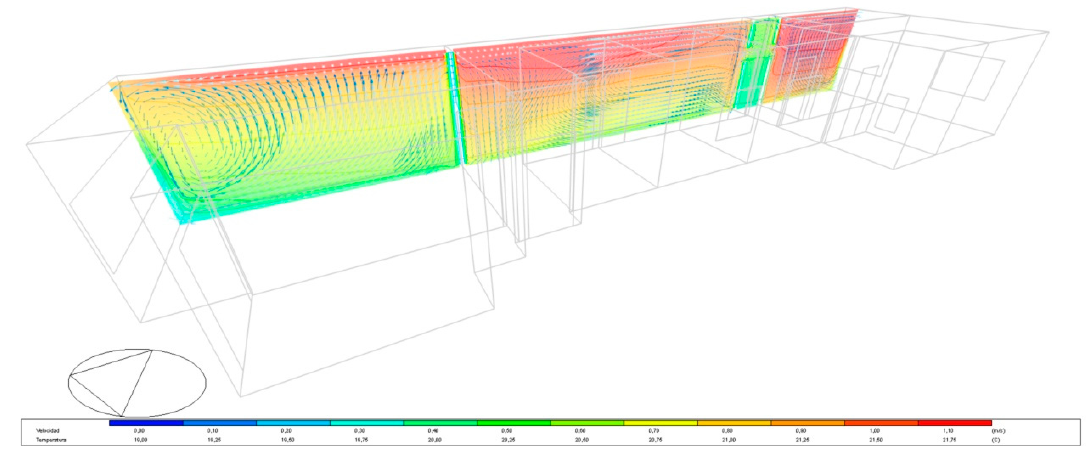
Figure 25. The radiant system via TCP panels; 1 February 2015, 9:00 a.m. Table 8. The calculation of energy demands and CO 2 emissions of the 3 OP.